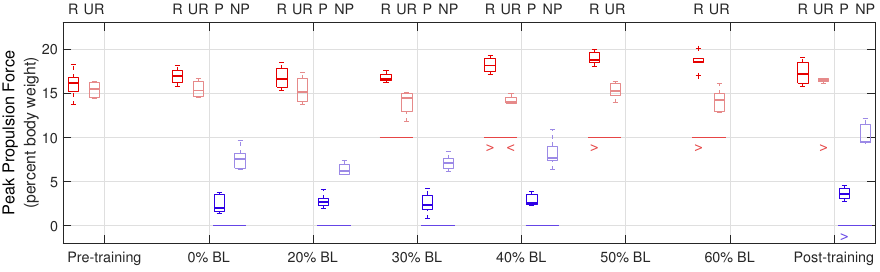
Figure 11. Boxplots of peak propulsion forces in the pilot study. Propulsion impulses are shown in Figure 12. For the healthy participant, significant differences between the two legs were found in the pre-training ( p = 0.038), 0% BL ( p < 0.001), 40% BL ( p = 0.014), 50% BL ( p = 0.008), and 60% BL ( p = 0.002) conditions. With GPT resistance and in the post-training condition, the healthy participant almost always generated significantly higher propulsion impulses, compared to the pre-training condition ( p < 0.033 in all cases), except the unresisted leg in the 0% BL and 20% BL conditions. For the stroke participant, the non-paretic side always had significantly higher propulsion impulses ( p < 0.028 in all conditions). In addition, significantly decreased propulsion impulse was found in the non-paretic leg in the 20% BL condition ( p = 0.029), compared to the 0% BL